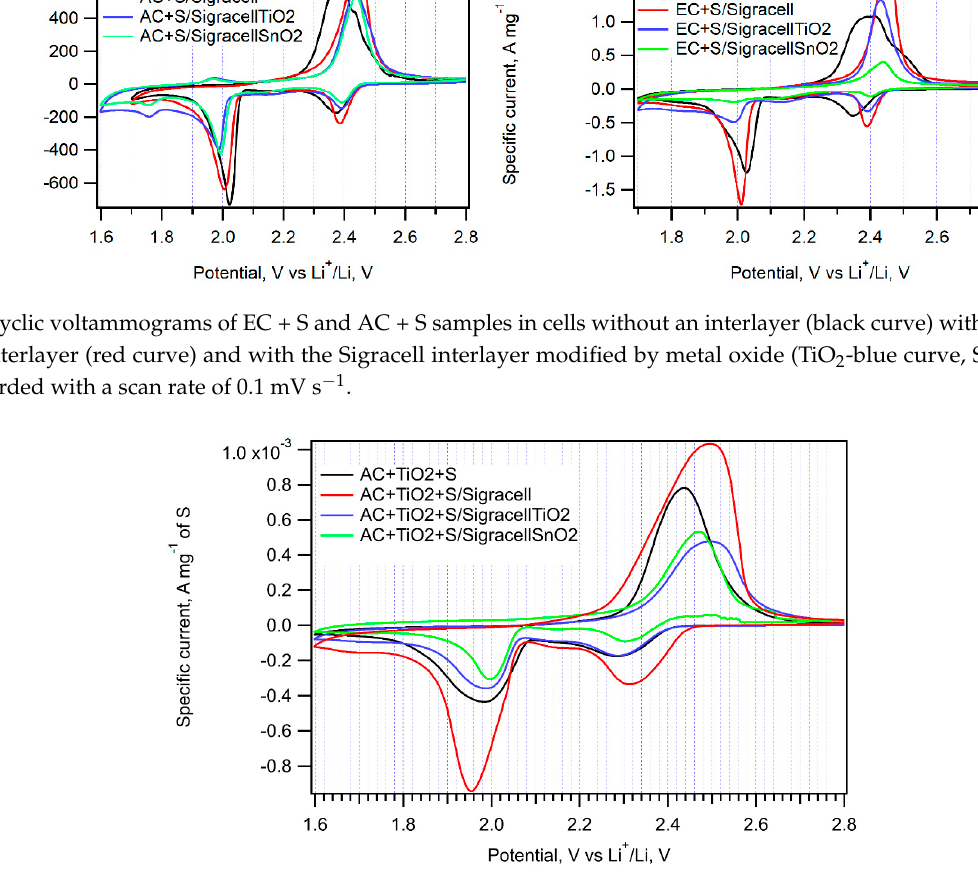
Figure 9. Cyclic voltammograms of the AC + TiO 2 + S sample in cells without an interlayer (black curve), with the pure Sigracell interlayer (red curve) and with the modified Sigracell interlayer (TiO 2 —blue curve, SnO 2 —green curve) recorded with a scan rate of 0.1 mV s − 1 . Table 2. Charge capacities (C) of the samples and cells, calculated from cyclic voltammetry. Charge capacities in the 3rd, 4th, and 5th column were measured in cells with an additional Sigracell barrier (SG—pure Sigracell, SG + TiO 2 —Sigracell covered by 50 nm TiO 2 layer by atomic layer deposition (ALD), SG + SnO 2 —Sigracell covered by 50 nm SnO 2 layer by ALD).